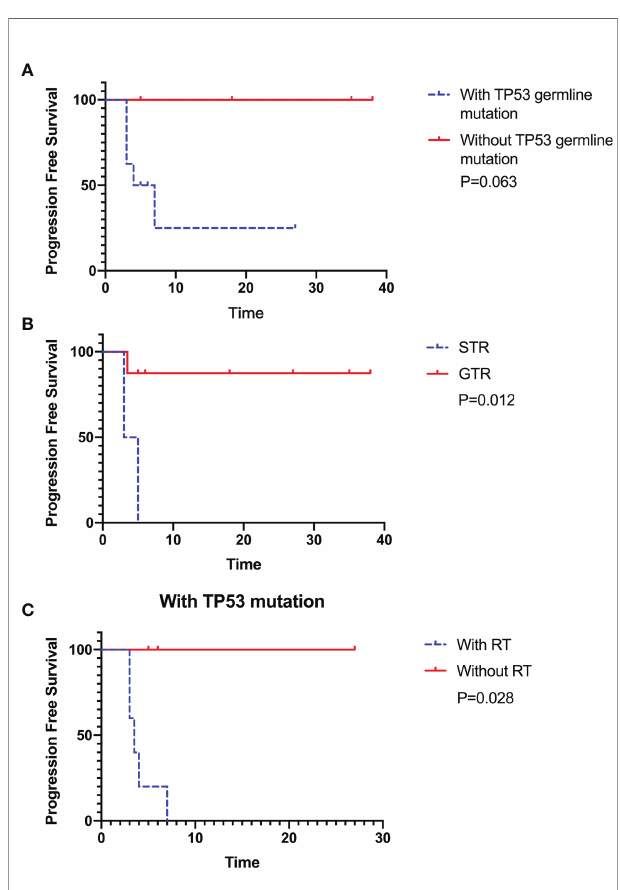
FIGURE 3 | The Kaplan – Meier estimates for progression-free survival (PFS) indicated that patients without TP53 germline mutation showed survival advantages, but there is no statistical signi fi cance (n=12, P=0.063) (A) . The patients receiving the gross total resection (GTR) and avoiding radiotherapy in patients with TP53 germline mutations showed signi fi cant survival advantages (n=12, P=0.012 and n=8, P=0.028) (B, C) . All patients were followed up until January 2,